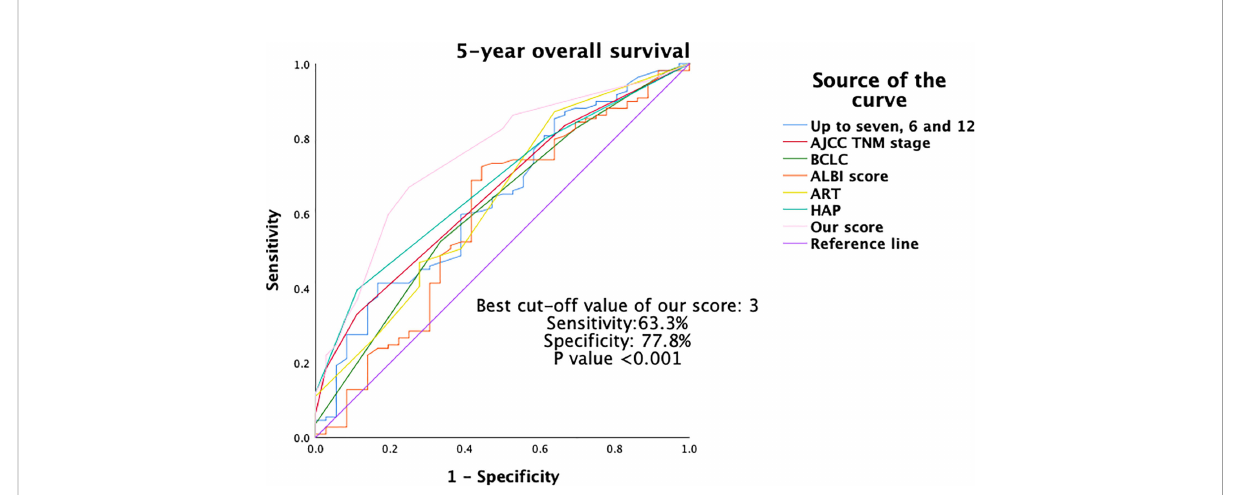
FIGURE 5 Area under the ROC (AUROC) of 5-year OS of different scoring systems. OS, overall survival; ROC, receiver operating characteristics.